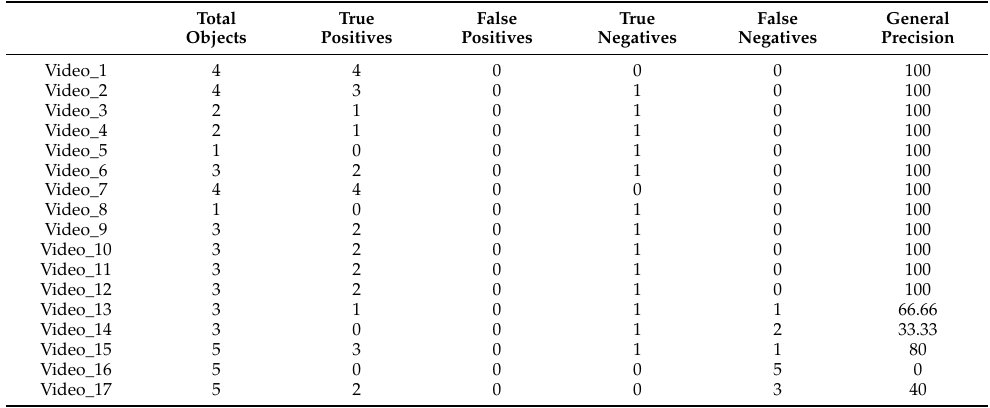
Table 5. Predictive model results.